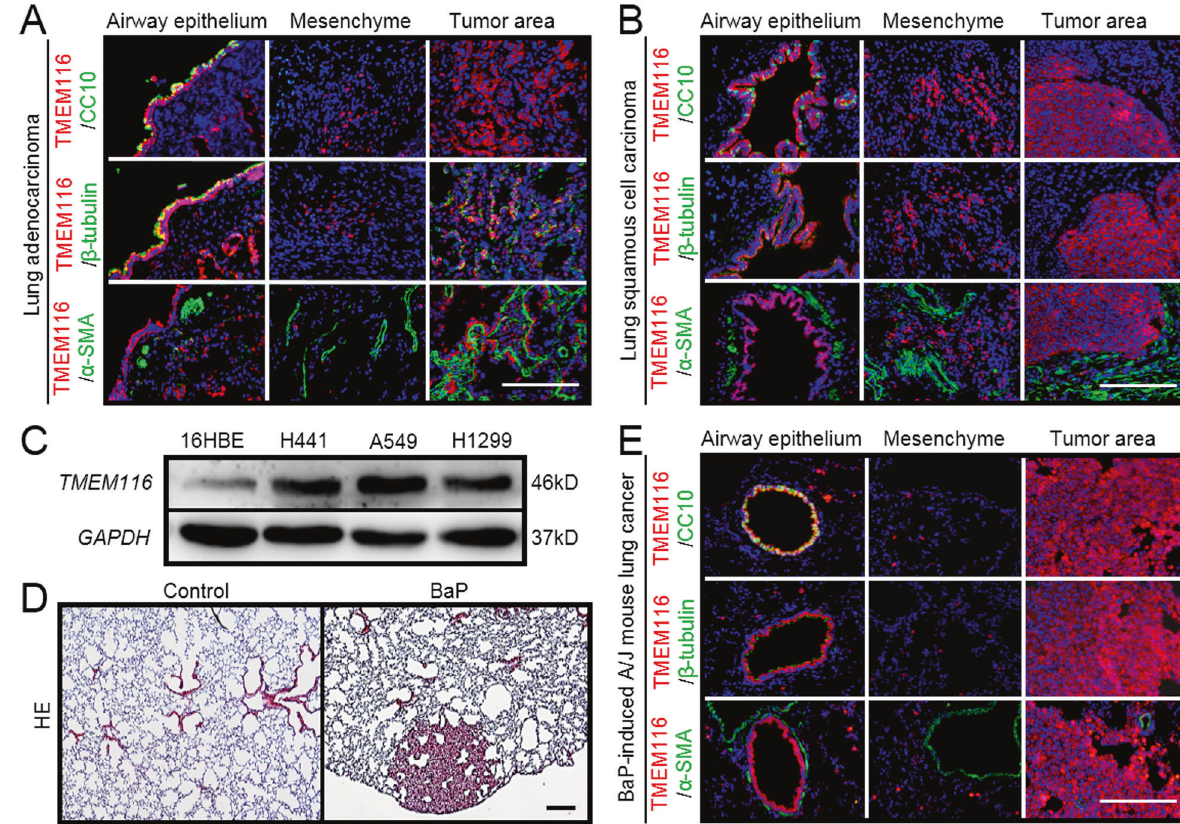
Fig. 2 TMEM116 expression is promoted in lung cancer. A Double IF staining analysis of TMEM116 and CC10, β -tubulin, and α SMA respectively in human LUAD tissues and adjacent tissues. B Double IF staining of TMEM116 and CC10, β -tubulin, and α SMA respectively in human LUSC tissues and adjacent tissues. C The expression of TMEM116 in the 16HBE, A549, H1299, H441 cells by western blot analysis. D H&E staining analysis of BaP-induced A/J mouse lung tissue. E Double IF staining analysis of TMEM116 and CC10, β -tubulin, and α SMA respectively in A/J mouse lung cancer tissues and normal tissues adjacent to carcinoma. Representative images from three independent experiments are shown above. Scale bar: 200 μ